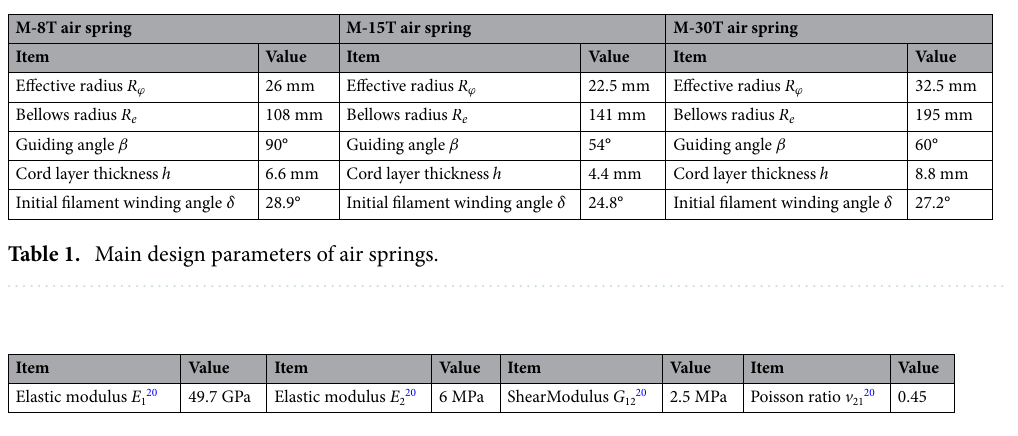
Table 2. Cord material parameters.